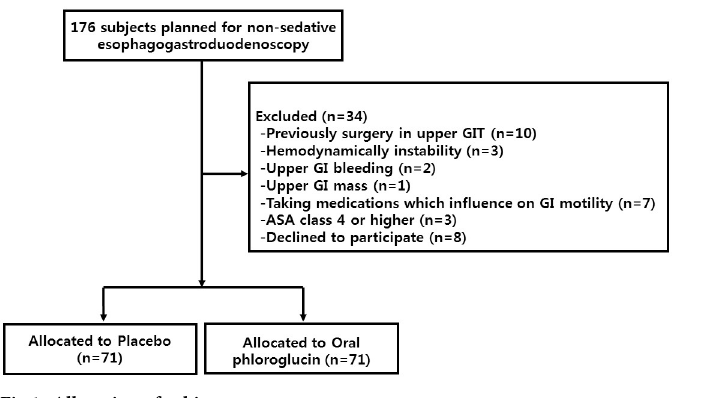
Fig 1. Allocation of